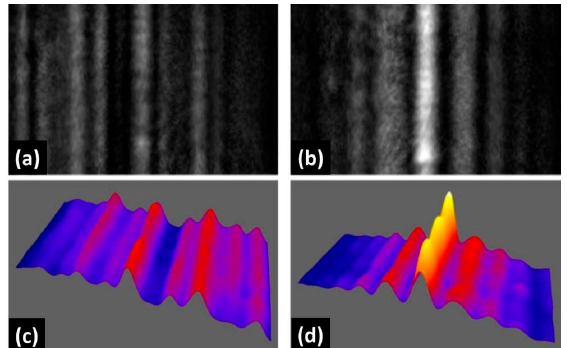
Figure 10. Improvement of interference contrast generated with configuration Com 1 at pulsed illumination by adapting grey level maps and background levels on SLM ( a , c ) unoptimized and ( b , d ) optimized intensity maps as 2D and 3D plots (laser source: Ti: sapphire laser oscillator; 7 fs pulses; distance from mirror: 15 cm; frequency conversion: BBO; voltage at Fresnel bi-mirror: 104.5 V; and FOV: 1.375 × 0.825 mm 2 ).